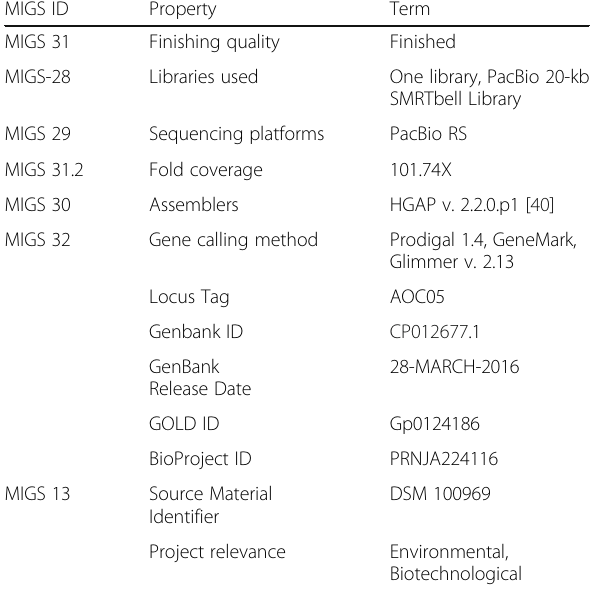
Table 2 Project